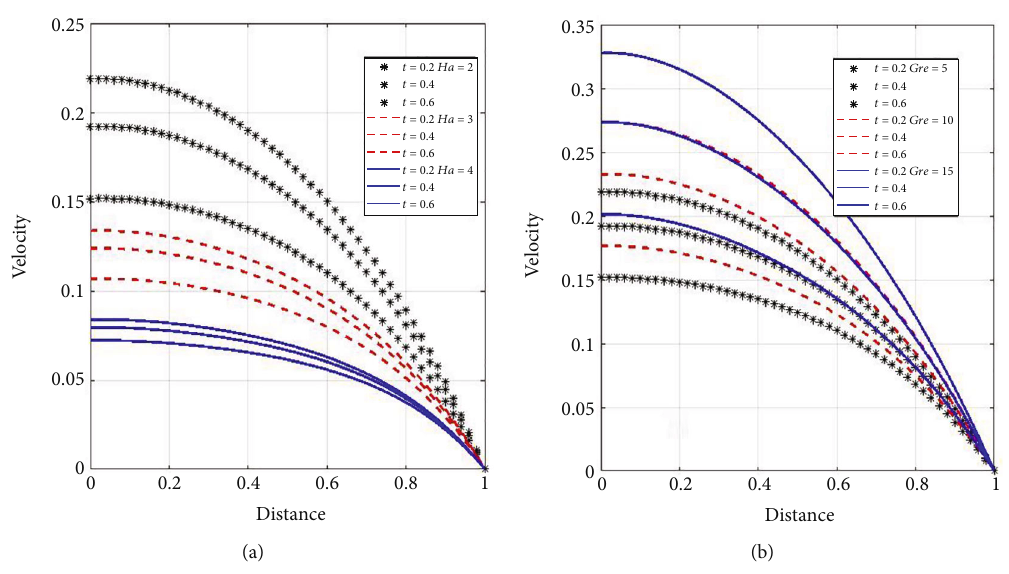
Figure 4: Unsteady-state velocity for Gre and Ha 2 .